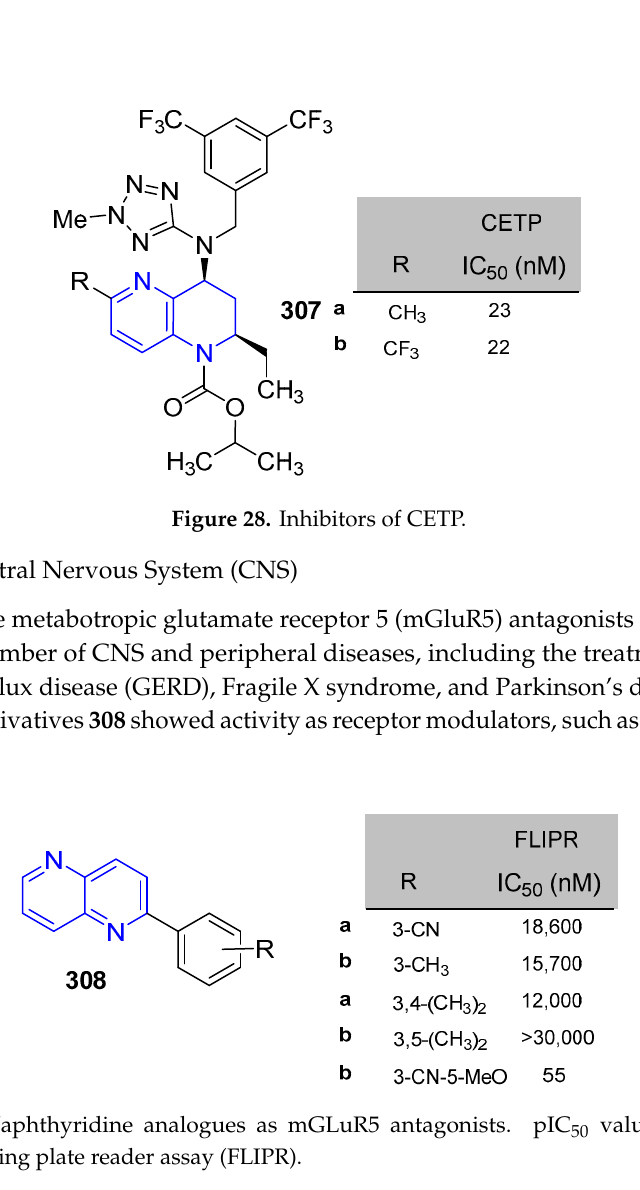
Figure 29. 1,5-Naphthyridine analogues as mGLuR5 antagonists. pIC 50 values measure by a fluorometric imaging plate reader assay (FLIPR).